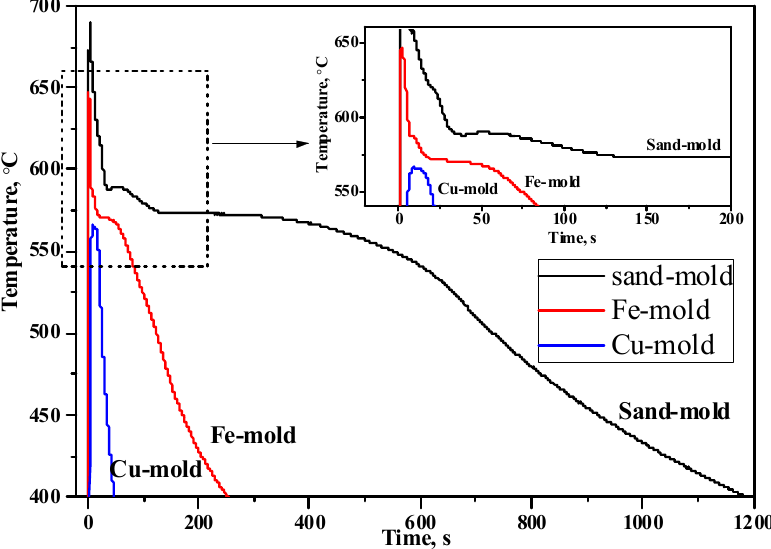
Figure 2. Cooling curves of sand/Fe/Cu-mold cast Al-10Si-0.5Mg alloys. The cooling curve of Cu- mold was difficult to capture because of fast cooling